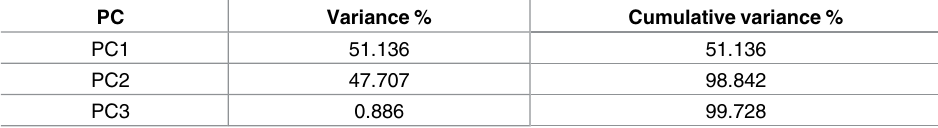
Table 2. Variance Distribution of the First Three PCs of the Six Moss Data